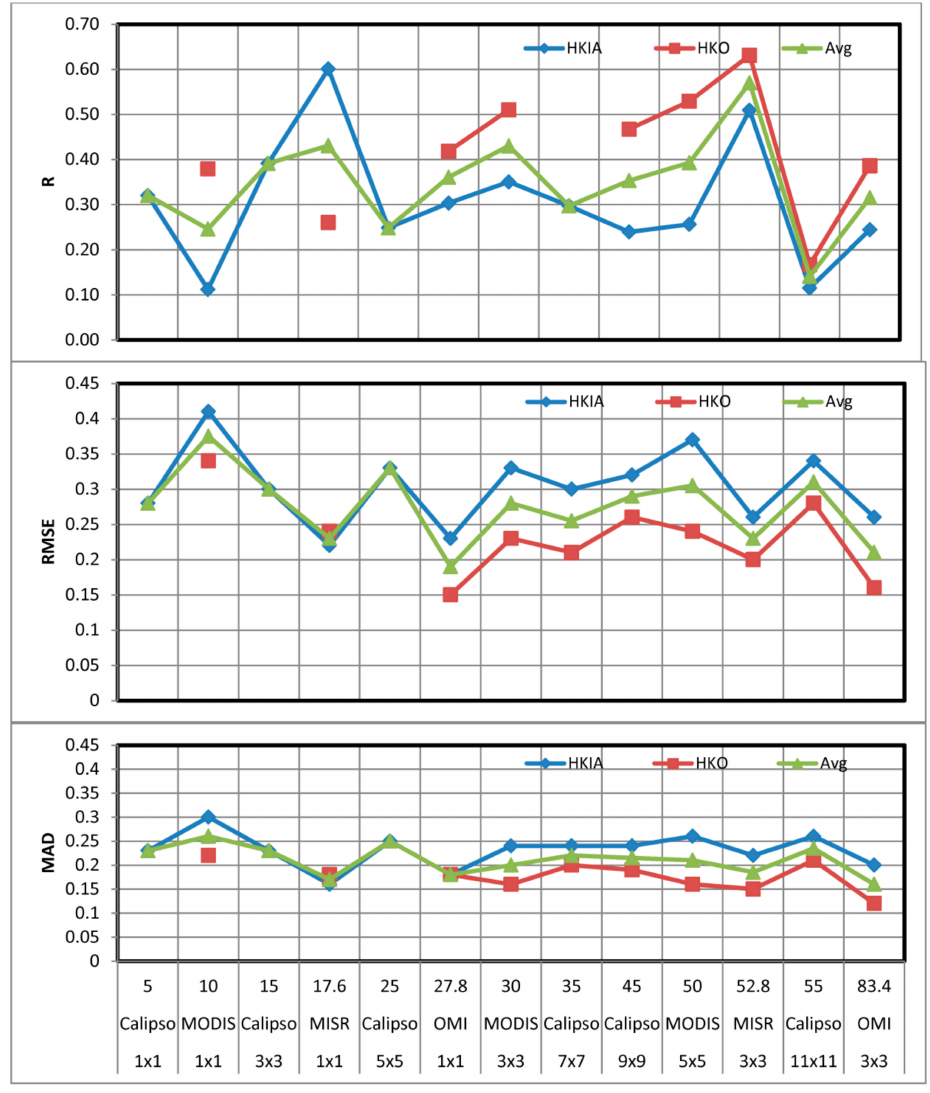
Figure 9. Variations in R ( top ), RMSE ( middle ) and MAD ( bottom ) at different spatial resolutions of MISR, MODIS, OMI and CALIOP for HKIA, HKO, and their Average. Spatial resolution (km), names of sensors and sizes of kernel window are labelled in the first, second and third x -axis, respectively. The scales of R, RMSE and MAD are on the y-axis. Negative correlation values for CALIOP AOD are not